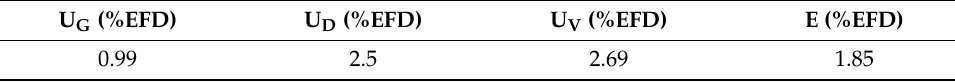
Table 2. Results of validation uncertainty.